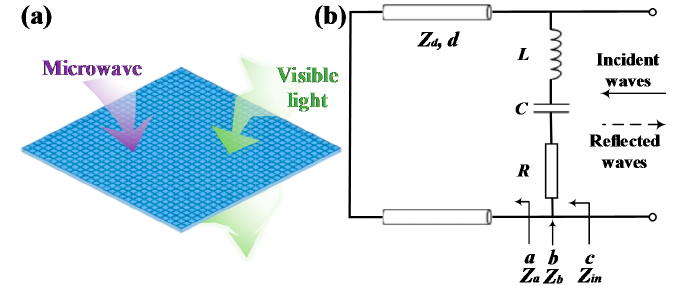
Figure 1. ( a ) The concept of OTMMA; ( b ) the equivalent circuit model of metamaterial